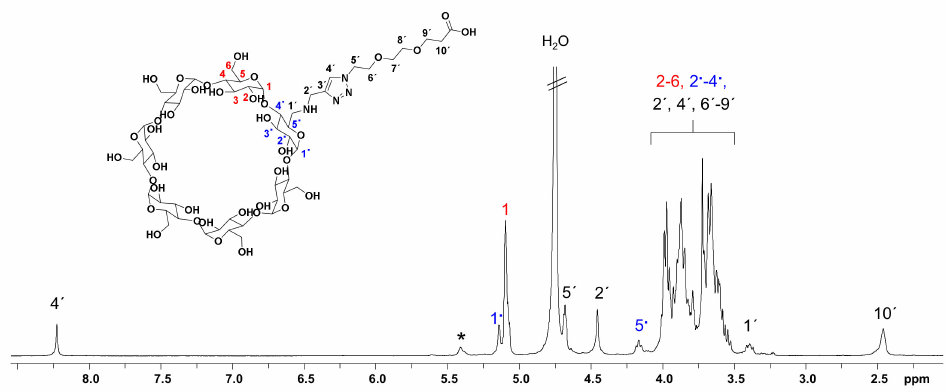
Figure A1. 1 H NMR spectrum of β CD-PEG-CO 2 H in D 2 O. * unknown 1 H NMR signal next to anomeric protons (1 and 1.) of β